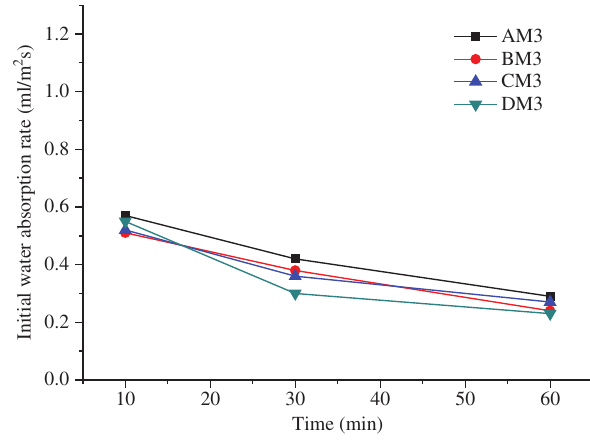
Figure 8: Initial surface absorption of AAFA geopolymer with the alkaline solution/binder ratio of 0.35 vs. time.